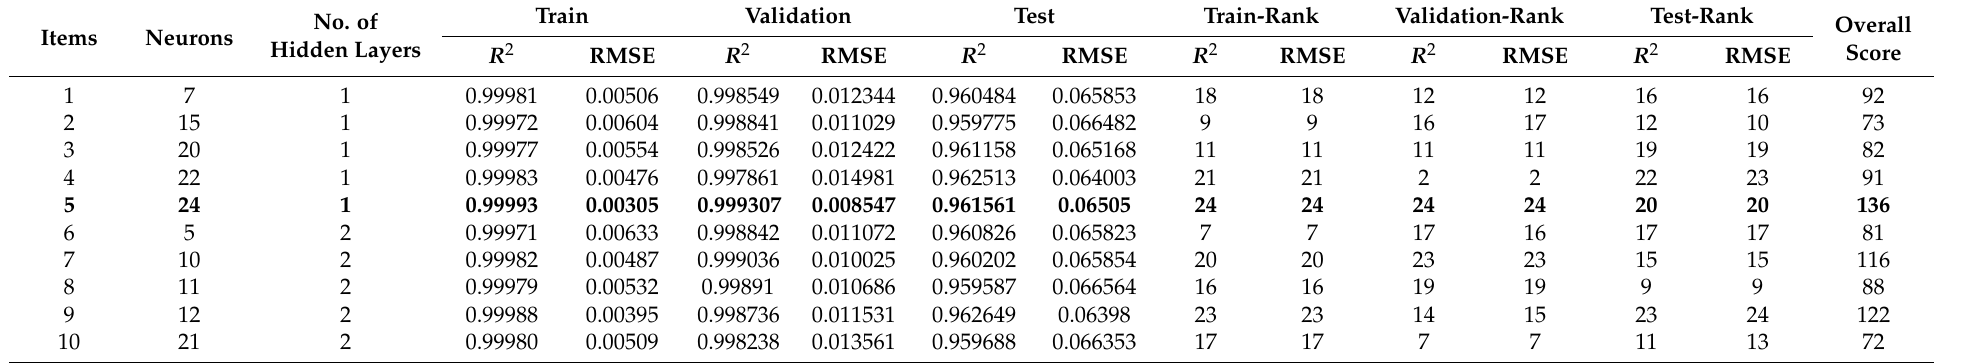
Table 5. Selecting the optimal ANN model with respect to hidden layers and neurons for the Germany dataset.